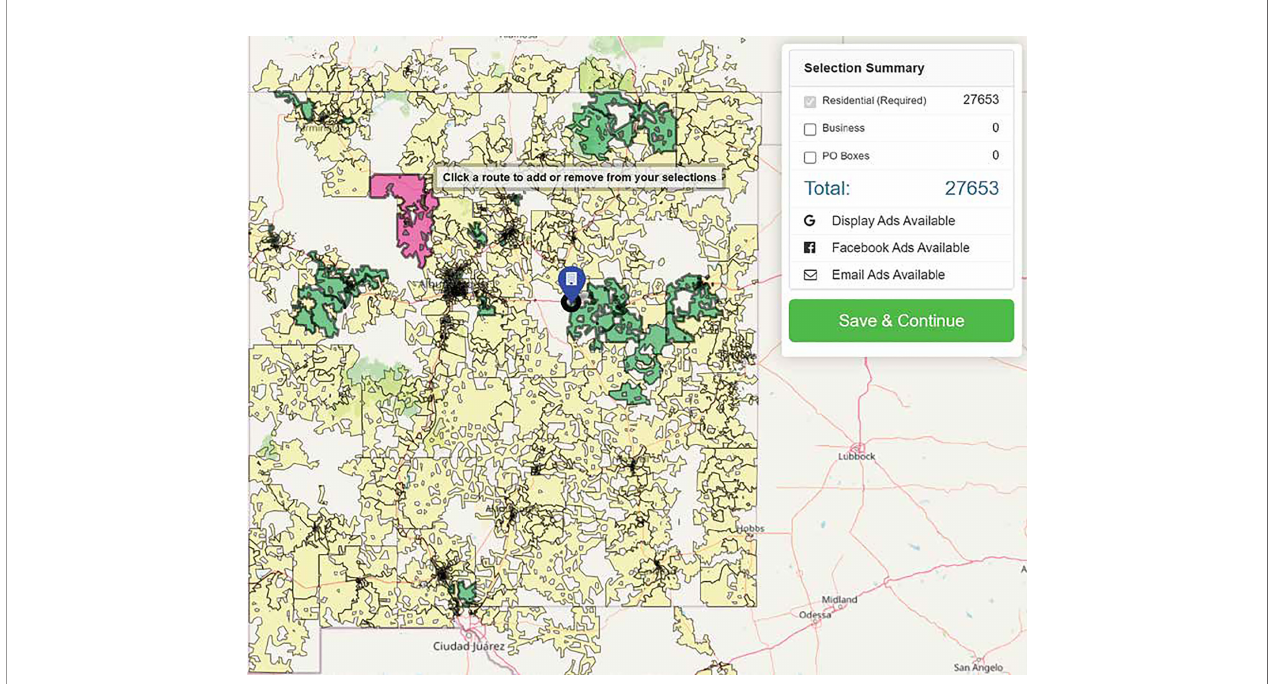
FIGURE 1 | Online Mapping tool provided by Taradel to select speci fi c mailing